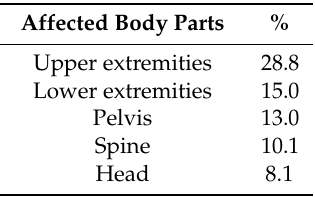
Table 2. Most often affected body parts.